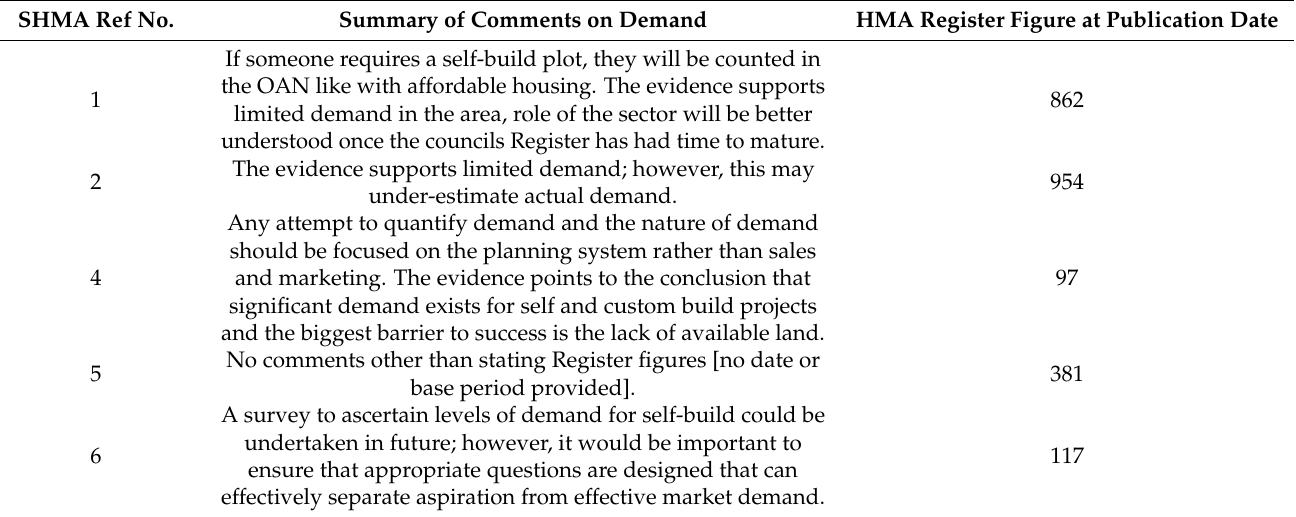
Table 8. Summary of comments on calculating demand in SHMAs whom did not produce a demand figure. SHMA Ref